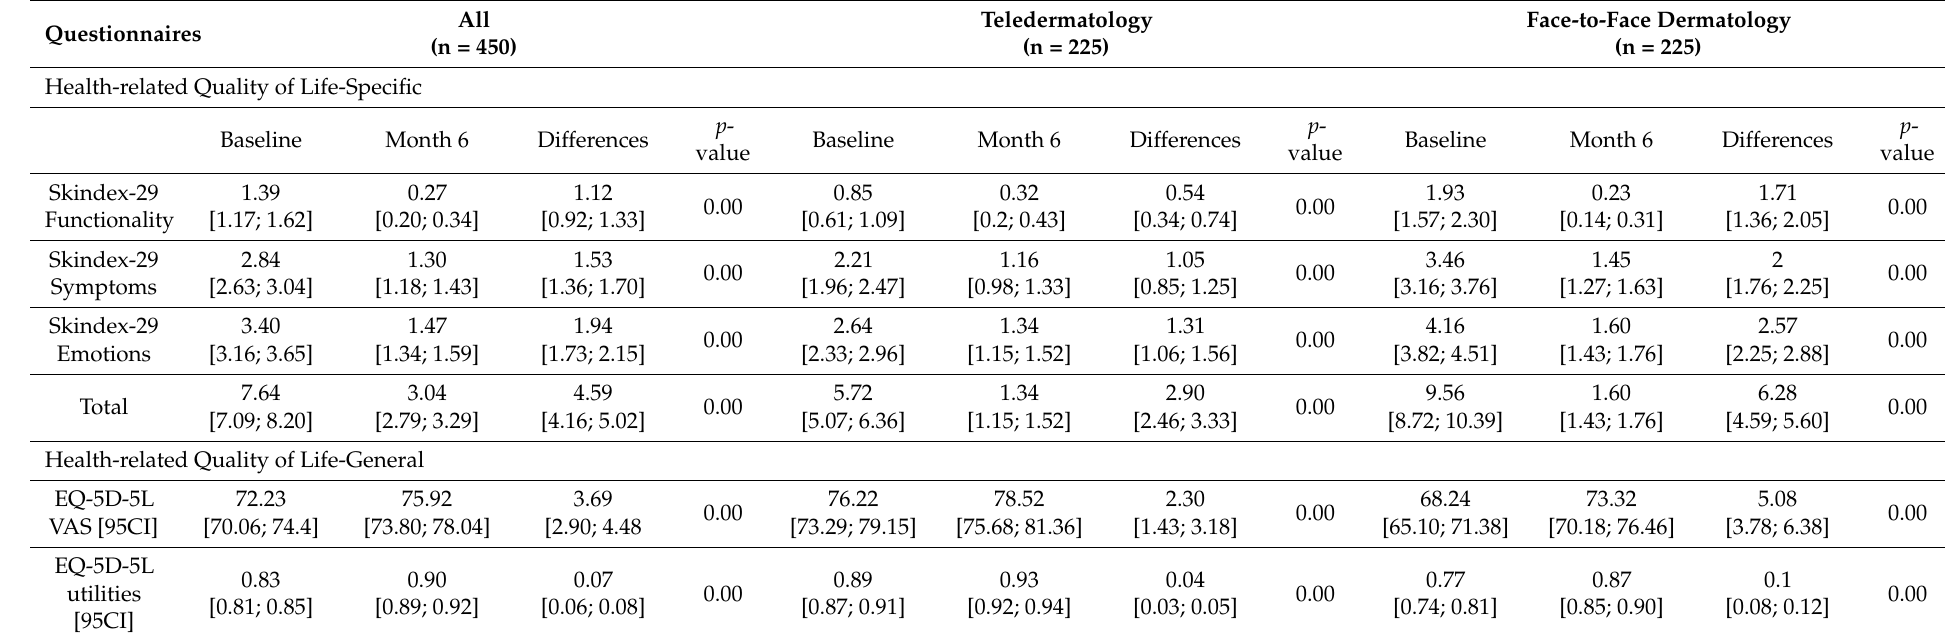
Table 3. Health-related quality of life at 6 months.